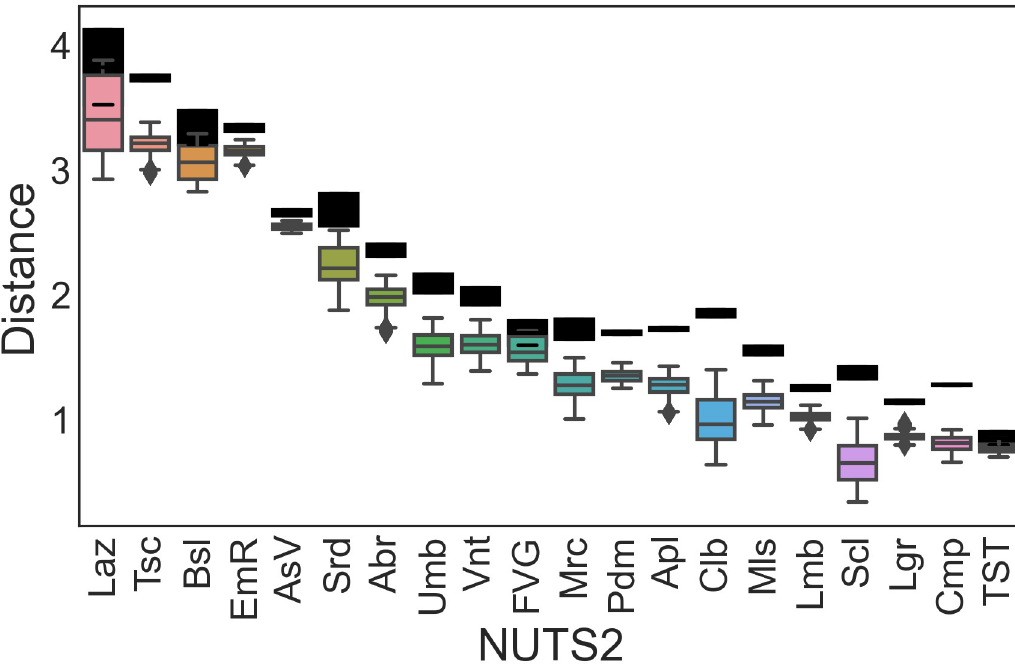
Fig 1. Boxplots of distributions of yearly cumulative distance between modelled and reported expenditures. Black rectangles show the range of yearly cumulative distance between the reported EC payments and reported expenditures to Italian NMAs.